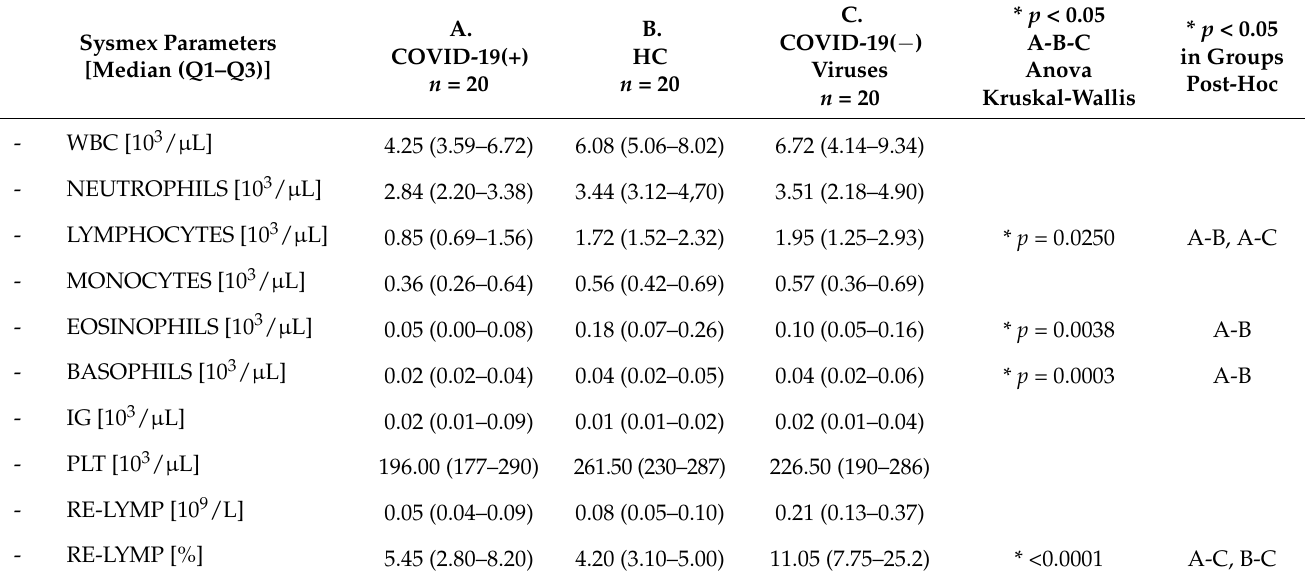
Table 2. Proportion of Sysmex morphological parameters in patients: with positive COVID-19 test—group A, control group (HC)—group B and the group with other virus infections with negative COVID-19 test—group C. Data expressed as median (Q1–Q3).